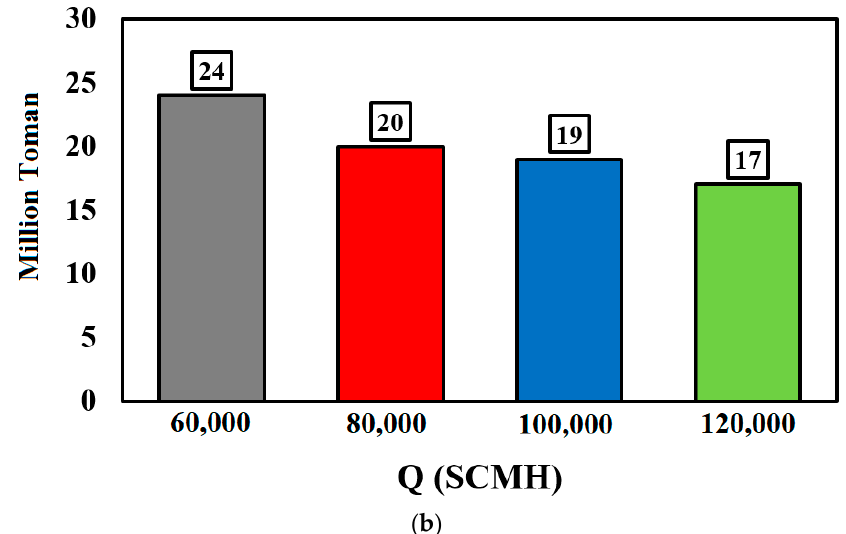
Figure 21. ( a ) The monthly reduction in gas consumption, and ( b ) the economic savings at different gas mass flow rates in one